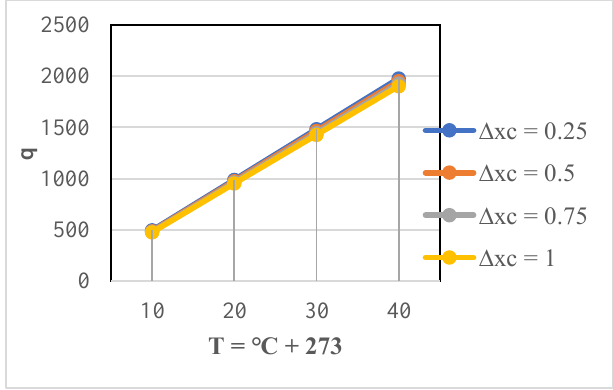
Fig. 2. Graphical presentation between heat flux and temperature at ∆𝑥 = 5 𝜇𝑚 , thickness of copper composite. 𝑎